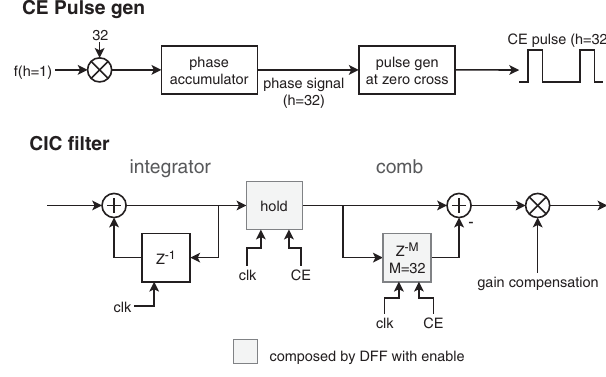
FIG. 8. Simplified block diagram of the tracking CIC